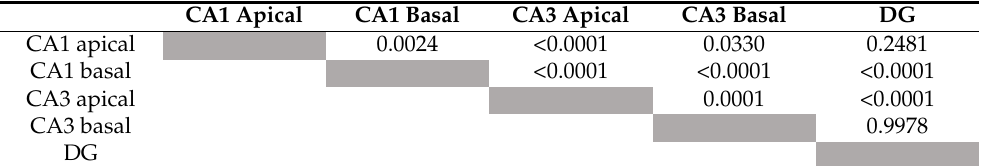
Table 6. Summary of the P-values from Šid ă k’s post hoc analyses for the comparison of the different hippocampal subregions in Table